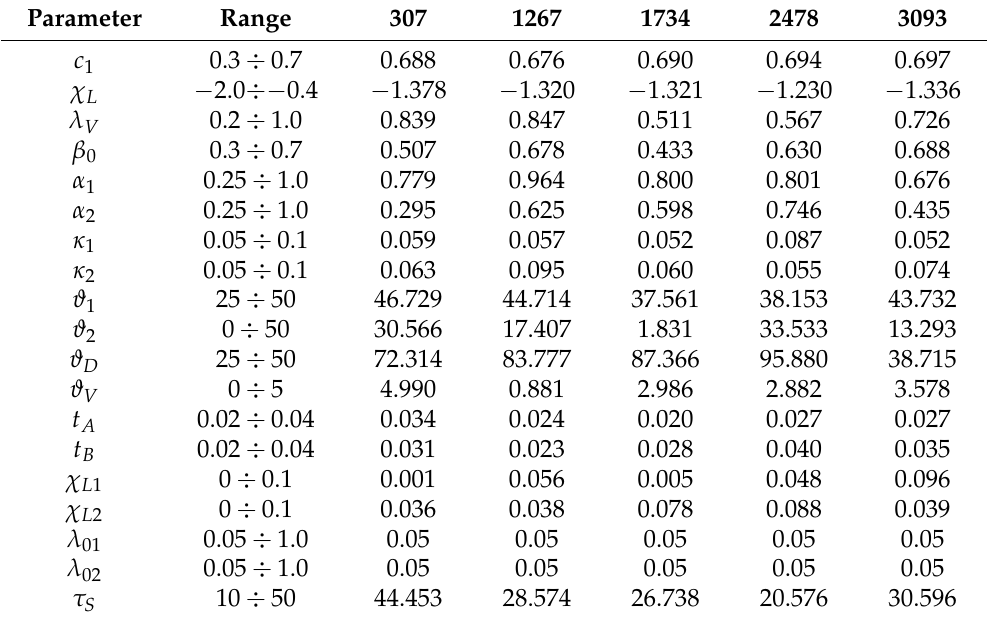
Table 6. The optimized parameters of the system and the ranges of their values.